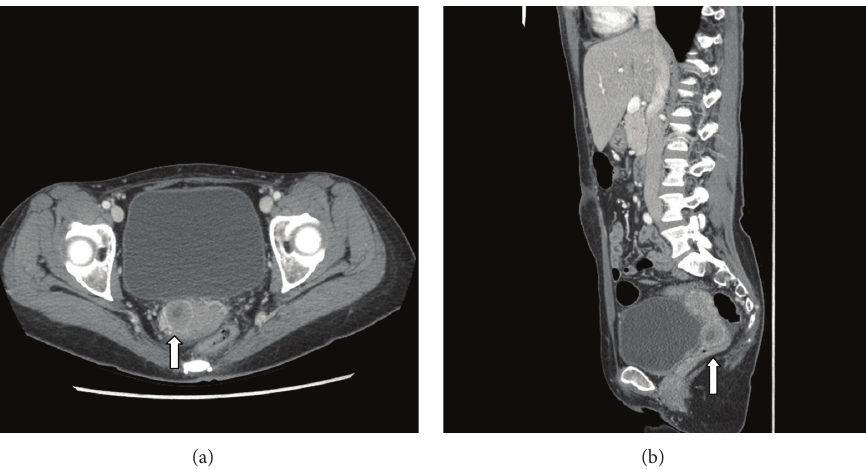
Figure 1: Axial (a) and sagittal (b) postcontrast CT of the pelvis. An enhancing cervical 2.3 cm × 2.2 cm mass (arrow) is on the right side of the cervix.